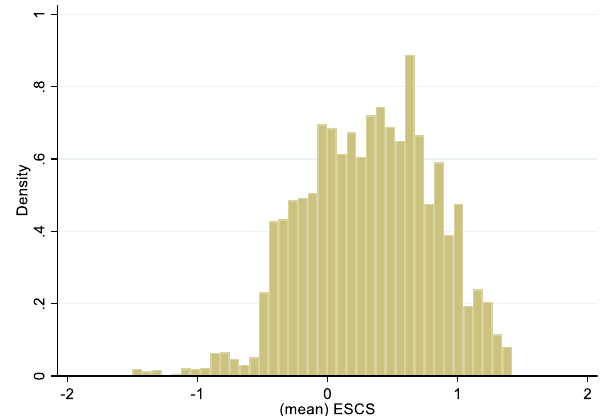
Fig. 2 Distribution of mean school index of economic, social and cultural status (school SES